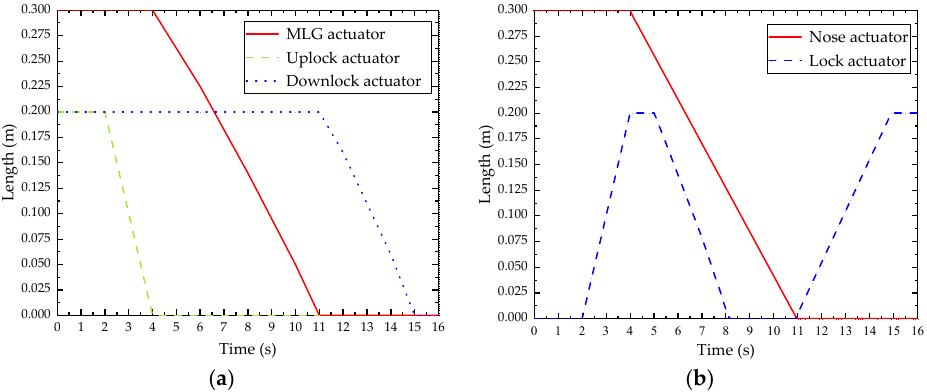
Figure 5. Simulation results: ( a ) Each actuator when the MLG is extending; ( b ) Each actuator when the NLG is extending.